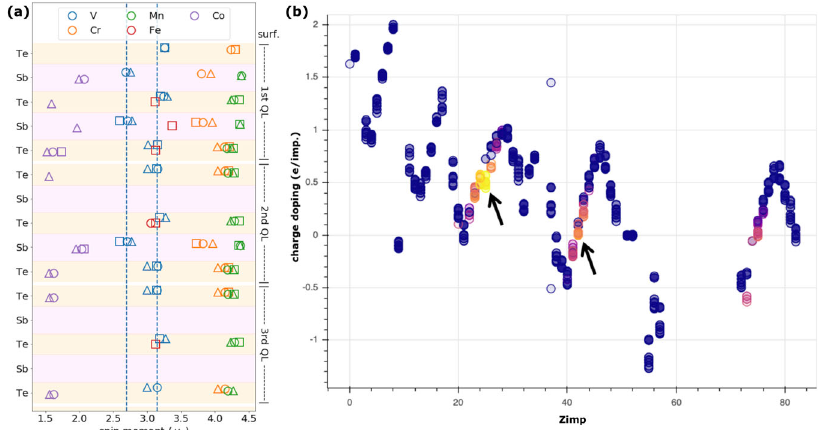
Fig. 8 Charge doping and magnetic properties of defects in Sb 2 Te 3 . a Layer and Fermi level dependence ( E F − 200 meV: △ , E F : ○ , E F + 200 meV: □ ) of the spin moment of some 3 d -impurities. The blue dotted lines serve as guides to the eye to highlight the difference in the spin-moment for Te and Sb layers. b Charge doping (in units of added electrons per impurity) vs. impurity atomic charge of all considered impurities. The color of the data points in ( b ) refers to the magnitude of the spin moment (blue: non magnetic to yellow: 4.4 μ B ). The arrows highlight magnetic 3 d and 4 d impurities which differ in their induced charge doping to the host crystal. The plot in ( b ) was generated using the JuDiT web interface 30 that accompanies the publication and can be used to visualize and export the result for future studies.